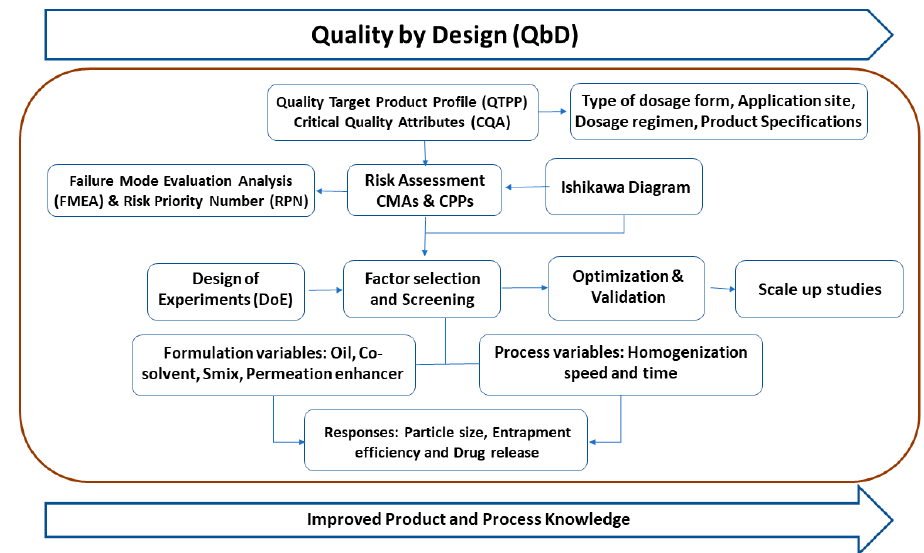
Figure 1. Representative image for steps involved in the QbD approach.